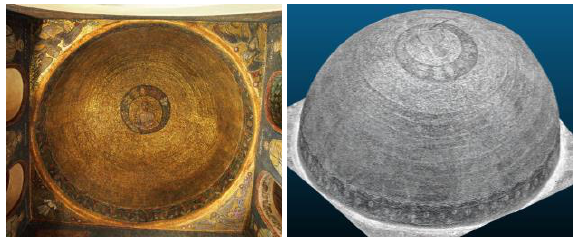
Figure 4. The vault used to explain the procedure in section 2.